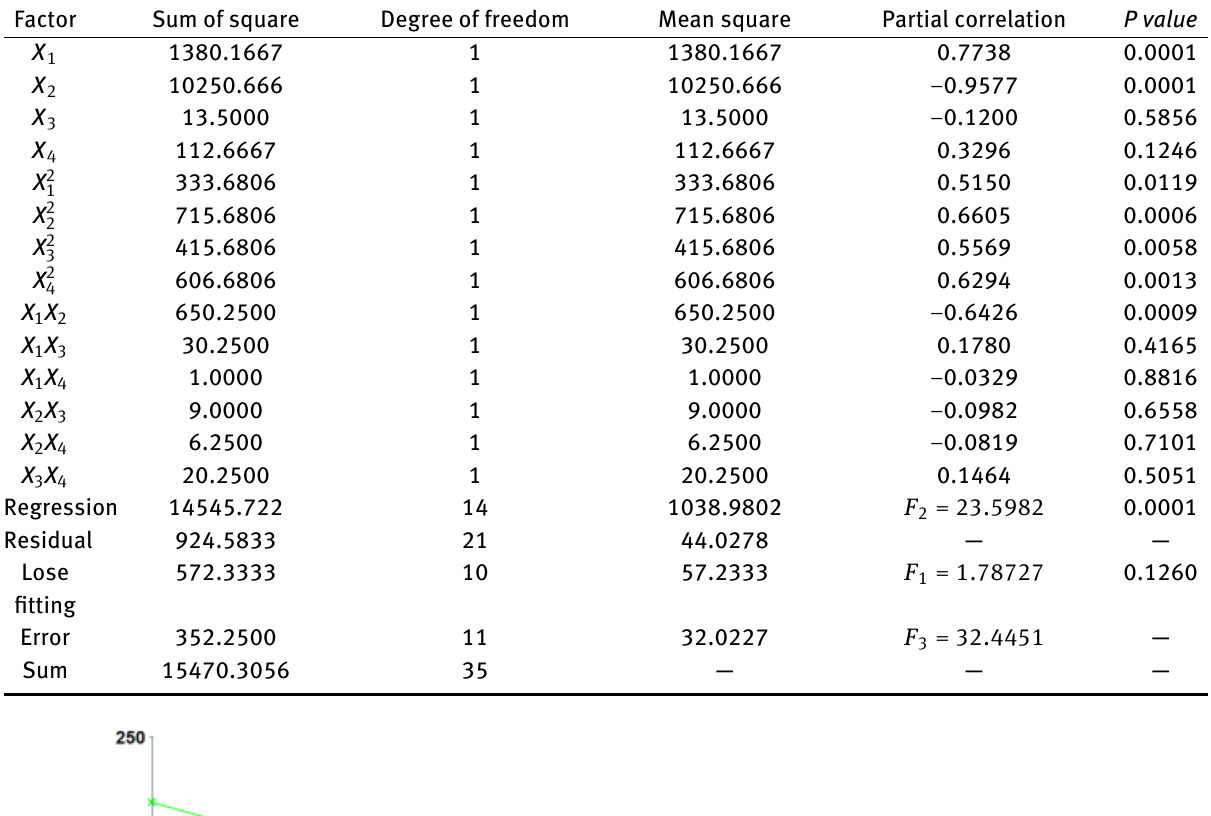
Table 6: Surface roughness test results analysis of variance Factor